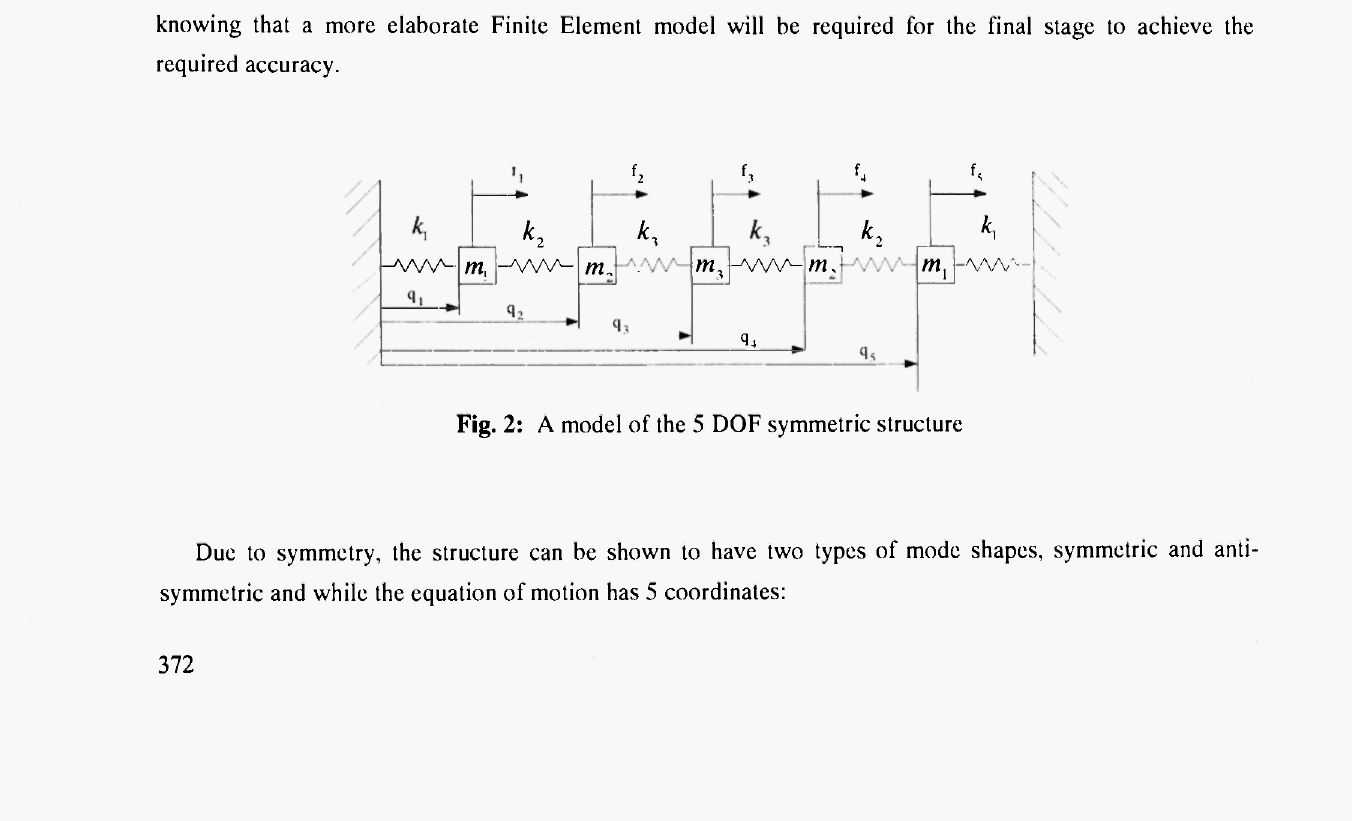
Fig. 2: A model of the 5 DOF symmetric